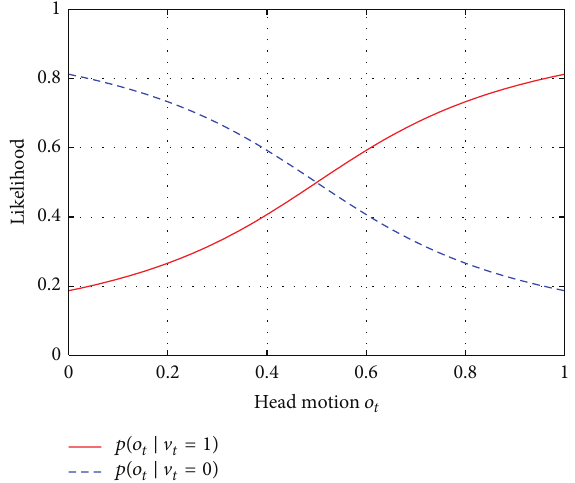
Figure 8: Sigmoid functions defining the observation likelihood of head motion for V 𝑡 = 0 and V 𝑡 = 1